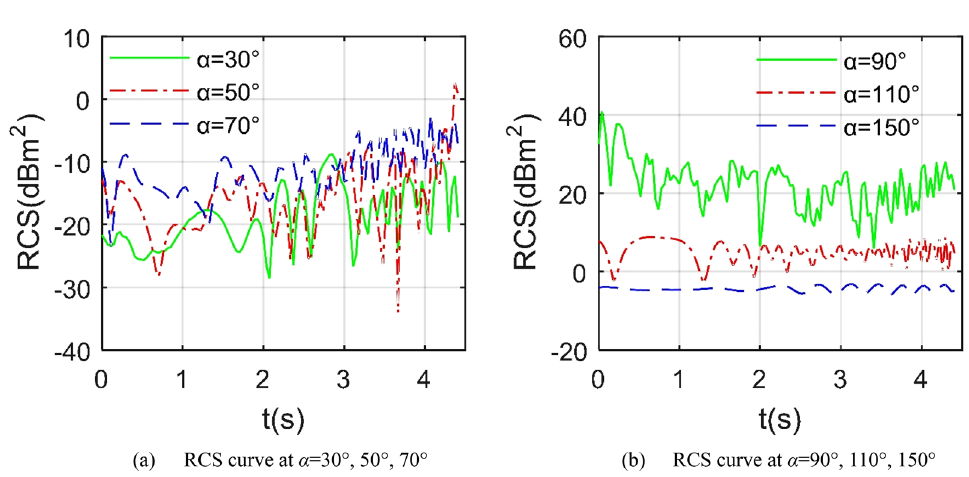
Figure 15. RCS of the aircraft in Z4 mode under various azimuths, β = 0°, f RH = 6 GHz, ω m1 = ω m2 = 0.1963